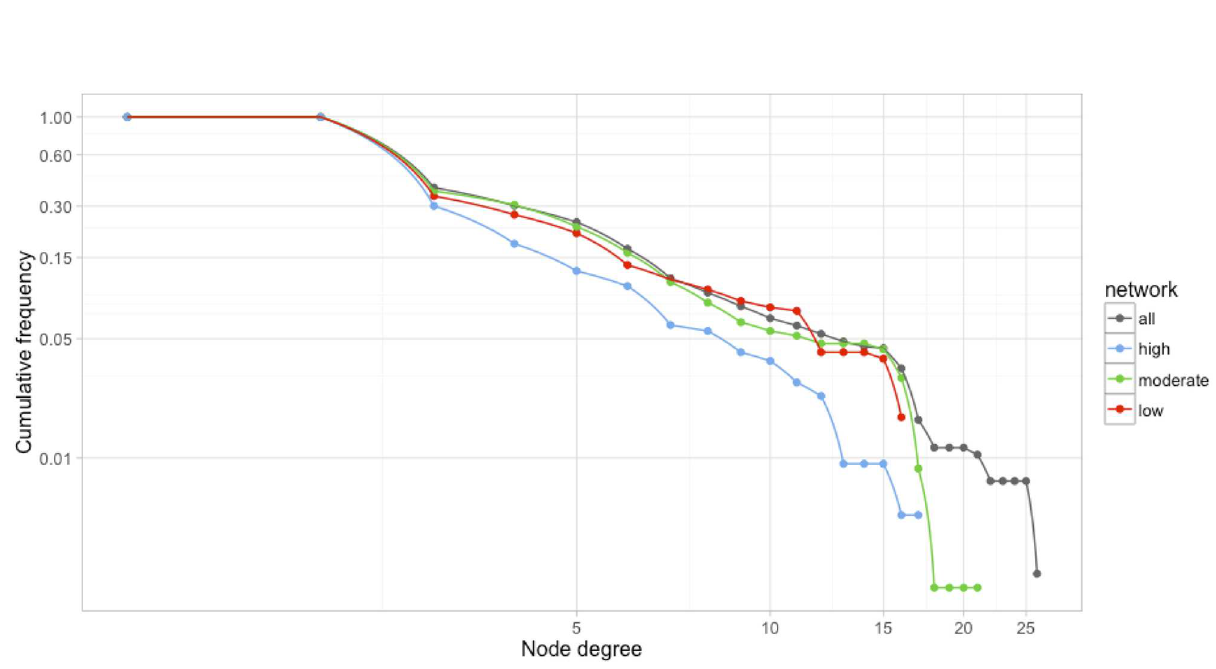
Fig 3. Cumulative frequency of node degree distributions. The cumulative node degreedistributionshows the cumulativenumberof nodes of each degreeclass. The distribution of degreevalues over all nodes characterizes the network as a whole.